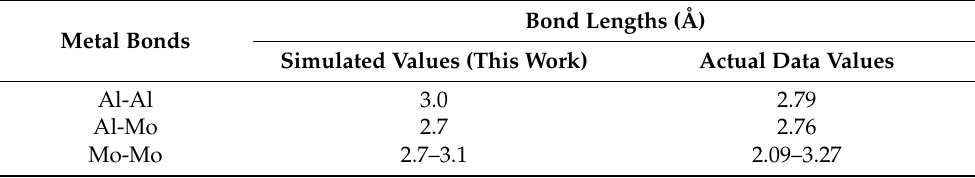
Figure 8. The epitaxial alignment of molten Al to Mo (100) plane. Table 2. A comparison of bond lengths between metallic Al and Mo with data figures